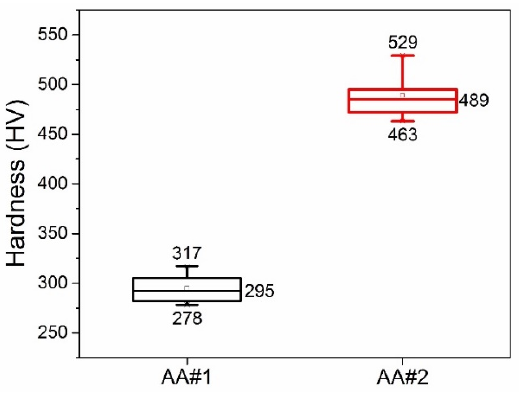
Figure 3. Microhardness of AAO measured by the Vickers method for AA#1 and AA#2 aluminum alloys (applied load: 100 g).